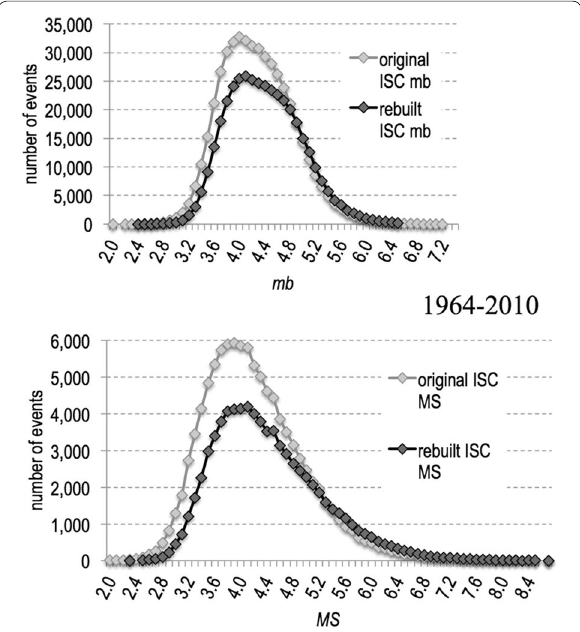
Fig. 11 ISC mb (top) and MS (bottom) magnitude frequency distribution in the original ISC and rebuilt ISC Bulletins